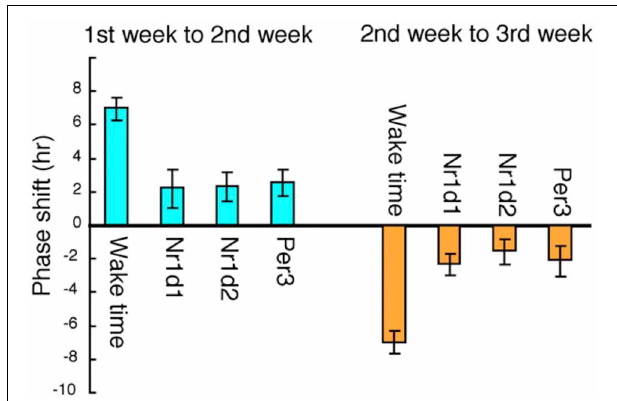
FIGURE 8 | Correlation between shift-work schedules and clock gene expression in six rotating shift workers. The average phase shift of waking-time and circadian gene expression was calculated among the six subjects. The phase delay from the 1st to the 2nd week and the phase advance from the 2nd to the 3rd week are shown. The life style was phase-delayed by about 7h from the 1st to the 2nd week, whereas the phase of circadian gene expression was delayed only by about 2h. The figures are adapted from Akashi et al.